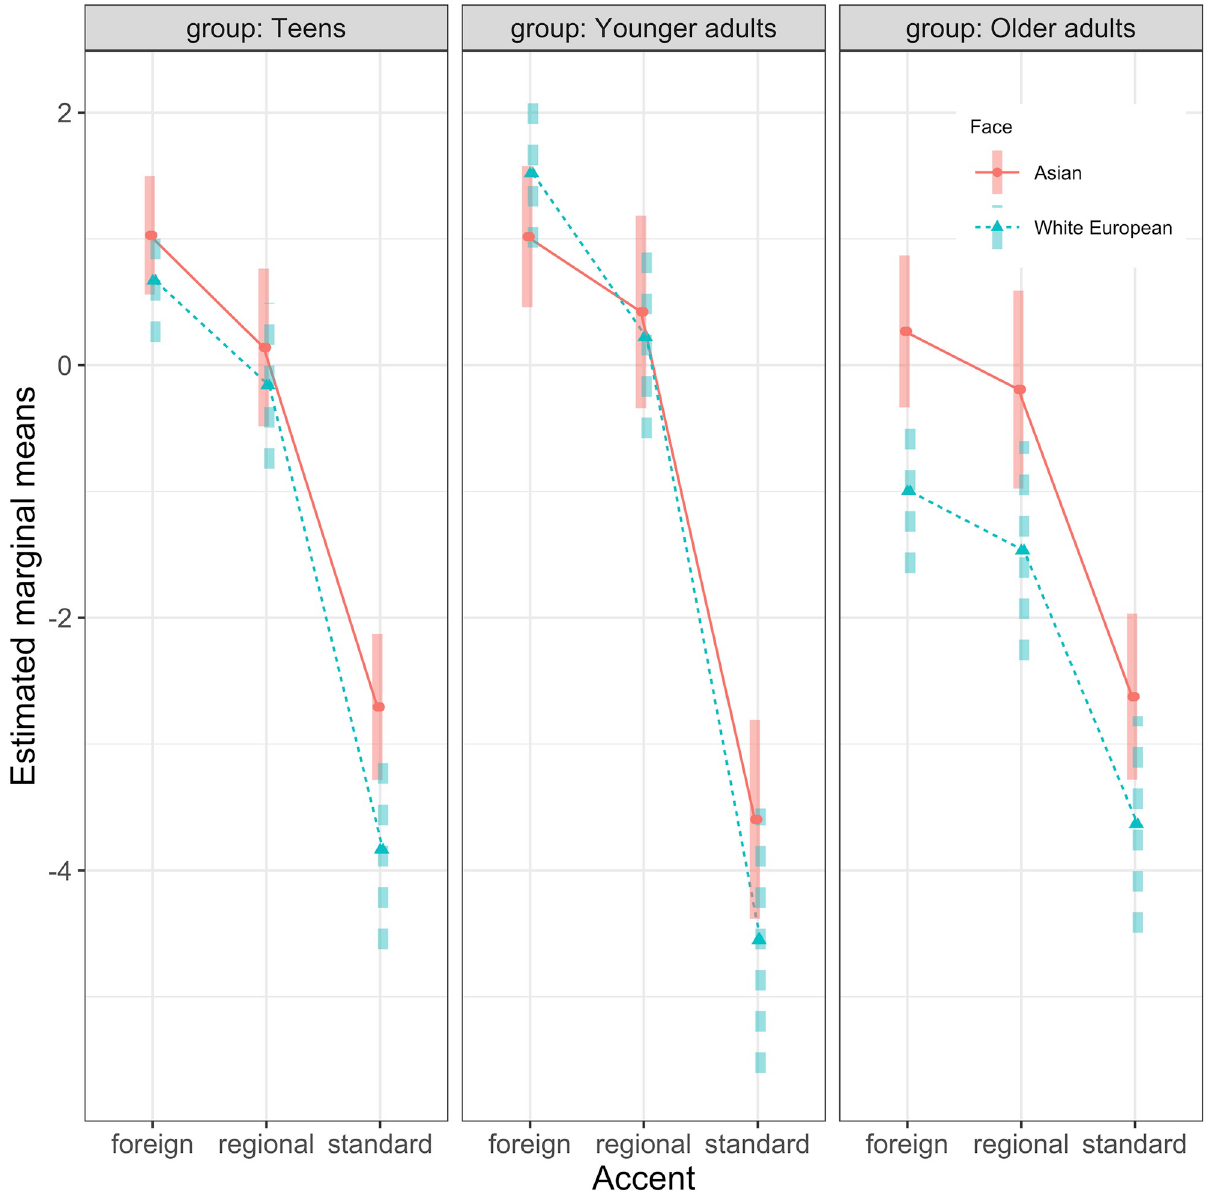
Fig 3. Accent ratings. Estimated marginal means (from the fitted clmm model) for accentedness ratings in the respective speech context and listener group. Error bars represent confidence intervals.